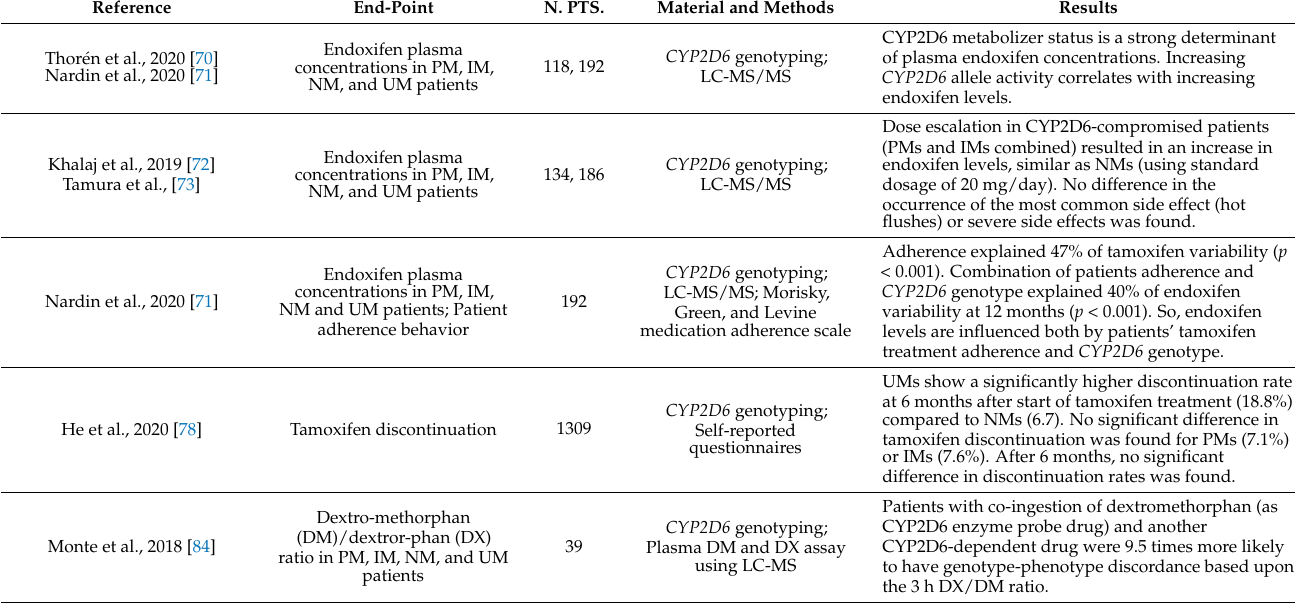
Table 2. Summary of described recent studies on CYP2D6 genotyping, and additional factors on plasma concentrations